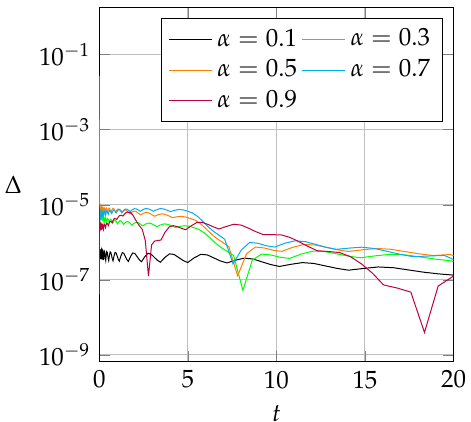
Figure 10. Relative error of the numerical solution of (110a)–(110d) using